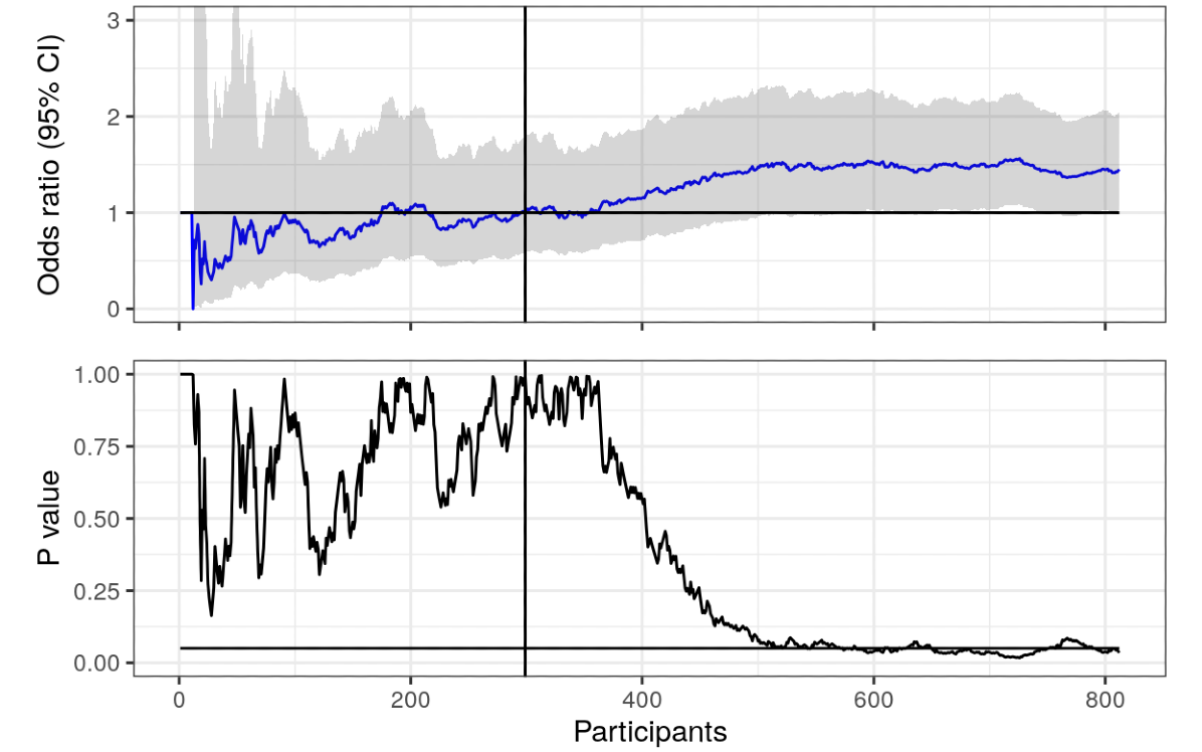
Figure 3. Prolonged abstinence (with sampled data): odds ratios and P values calculated using actual and sampled data from trial, plotted over time (number of responders in the study). Horizontal lines represent null value (OR 1) and the .05 statistical significance line. The vertical line represents where the first 6 months of recruitment ended.